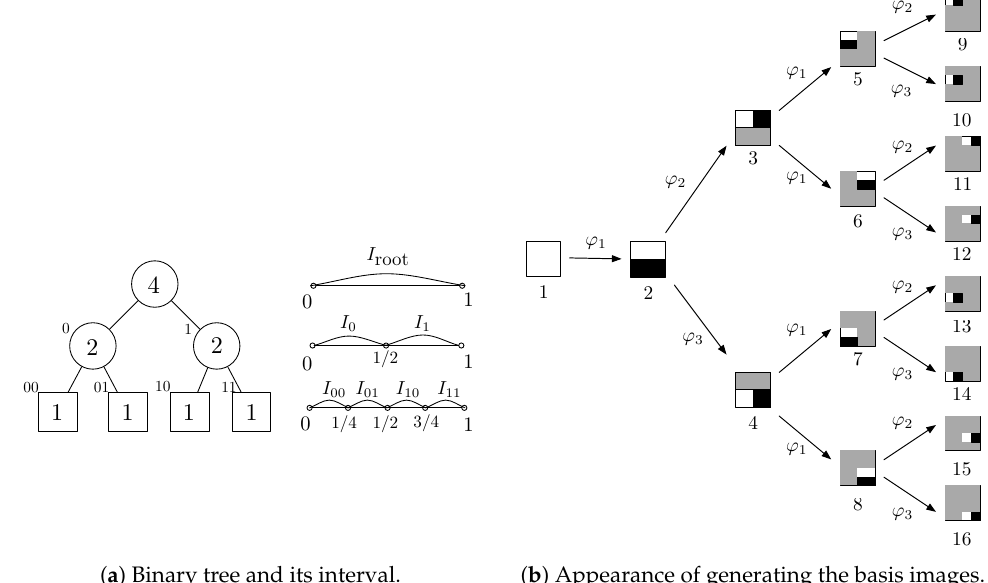
Figure 6. An example of OHT basis images based on a full binary tree having four